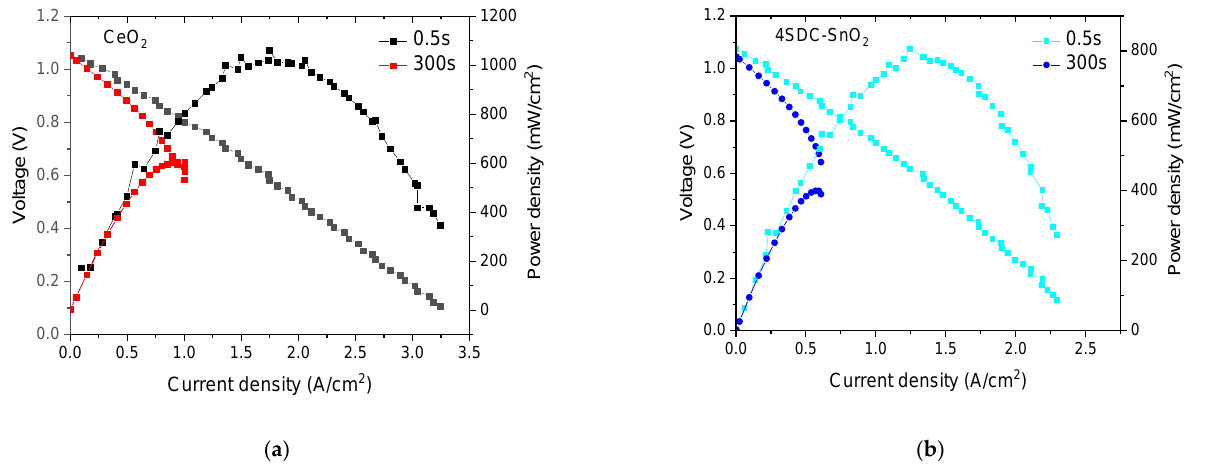
Figure 2. I – V – P curve of cells by sweeping on different time intervals ( a ) CeO 2 ; ( b ) 4SDC-SnO 2